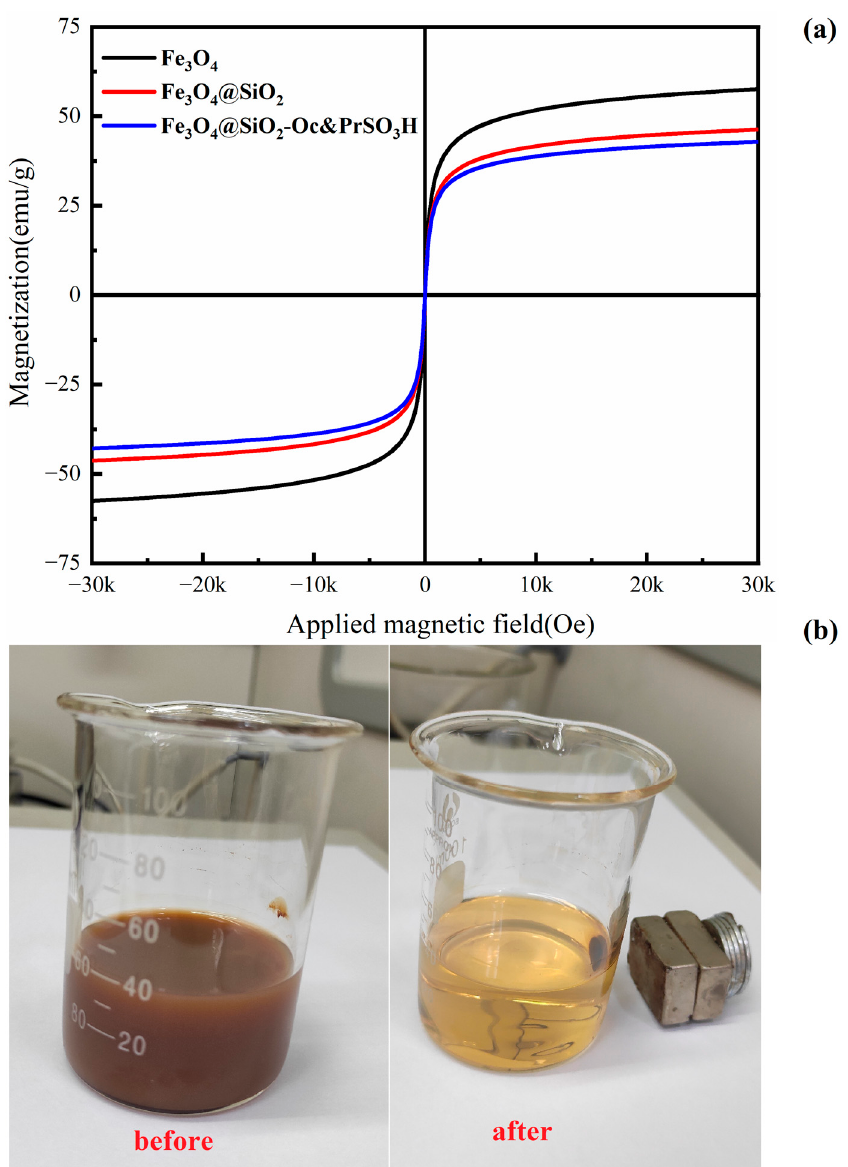
Figure 6. ( a ) The magnetic hysteresis loops of Fe 3 O 4 nanoparticles, Fe 3 O 4 @SiO 2 support, catalyst Fe 3 O 4 @SiO 2 -Oc&PrSO 3 H; ( b ) Separation process of catalyst Fe 3 O 4 @SiO 2 -Oc&PrSO 3 H from the reaction solution with an external magnet.